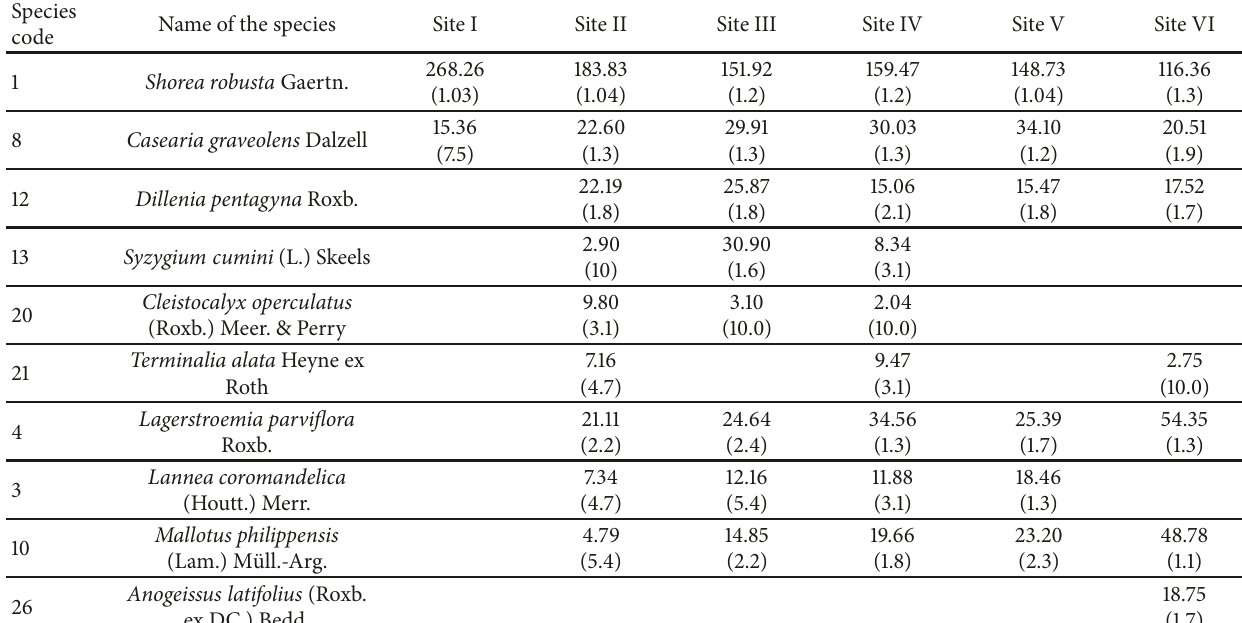
Table 12: IVI of predominant species and Morisita Index of Dispersion in Musharni Mai